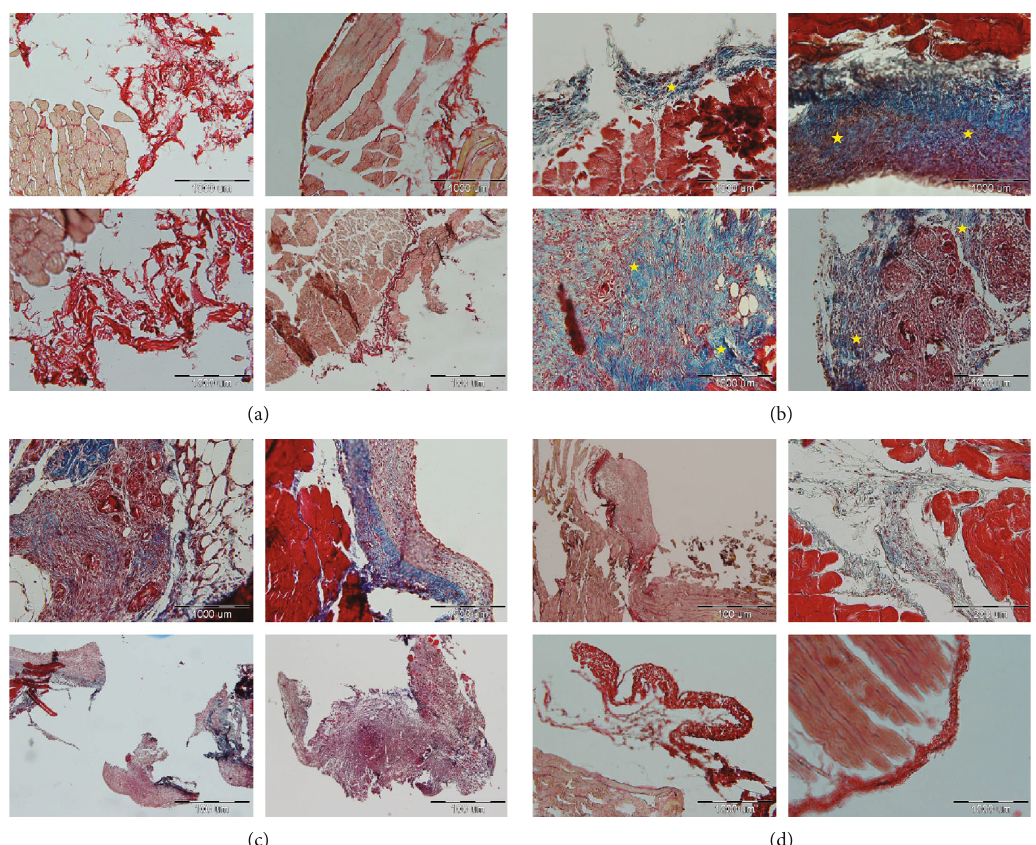
Figure 4: The e ff ects of di ff erent doses of PO on adhesion formation and collagen deposition by histopathological evaluation using Masson ’ s trichrome staining; blue colour intensities (marked with yellow stars) represent fi brosis and collagen deposition. Pathological imaging; (a) normal group, (b) control group, (c) PO at the dose of 100mg/kg, and (d) PO at the dose of 300mg/kg. The highest rate of tissue fi brosis (blue colour) and collagen deposition was observed in the control group (b) compared to the normal group (a), which had the lowest fi brosis rate. Conversely, the blue colour intensities as a marker of fi brosis and collagen deposition in both doses of the extract groups (100 and 300mg/kg) were signi fi cantly decreased compared to the control group (c,